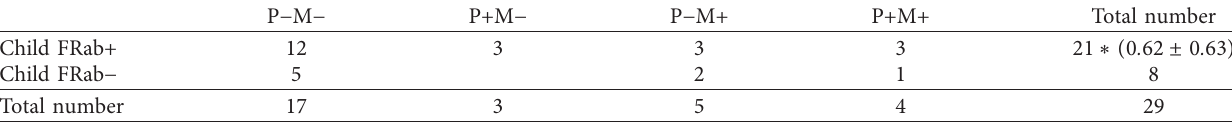
Table 2: The distribution of blocking and binding FR α autoantibodies in 29 children and their